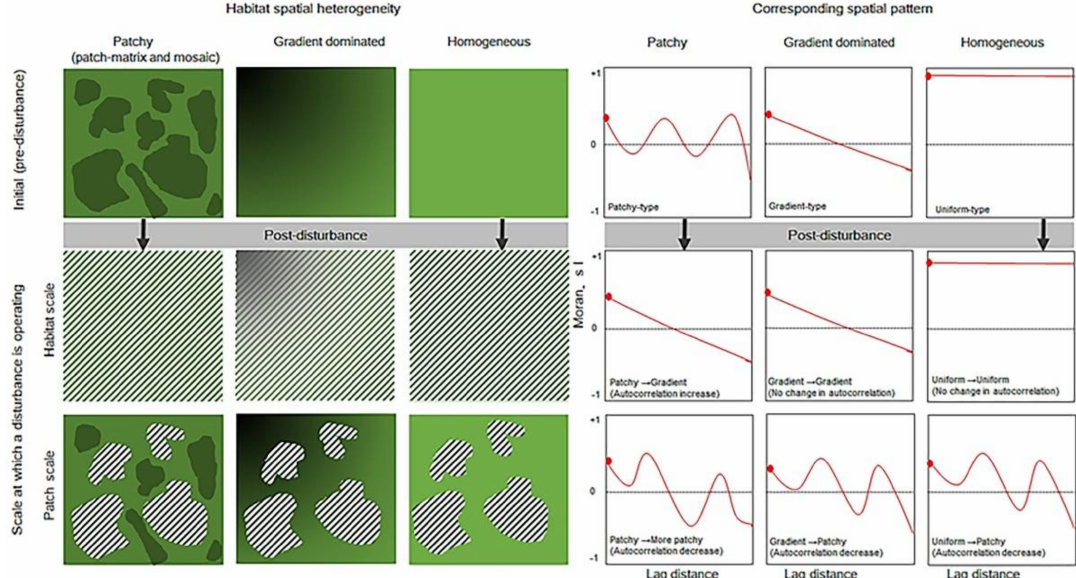
Figure 1. Conceptual diagram illustrating disturbance-driven changes in the spatial autocorrelation of biodiversity. The hatched lines in the figures indicate the spatial scale of disturbance, either over the entire habitat (when the hatched lines spread over the entire area) or within a patch (when the lines are spread within selected area). The corresponding spatial patterns (cf. spatial autocorrelation) are shown (right hand side of the figure) in the context of Moran’s